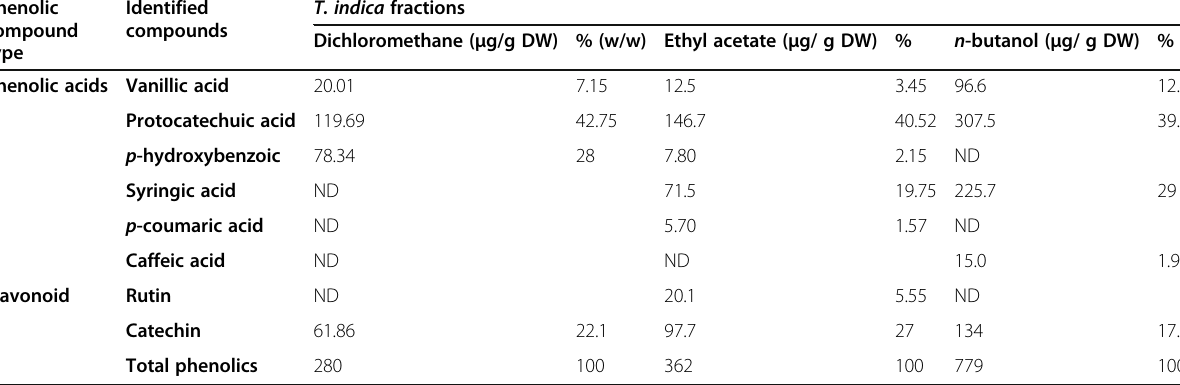
Table 3 Quantitation of the identified phenolic compounds in the three T. indica fractions Phenolic compound